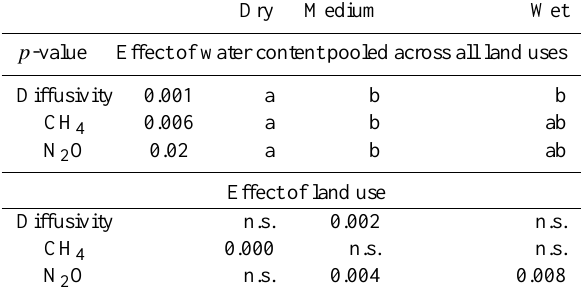
Table 3. The effect of water content and land use on gas diffusivity, CH 4 and N 2 O fluxes, as determined by ANOVA. Diffusivity data were LN transformed to improve the normality of their distribution. The p -value is reported for significant results, non-significant re- sults are indicated by n.s., and post hoc tests (Tukey’s) were used to determine how the three water contents differed. Different letters indicate where results were significantly different from one